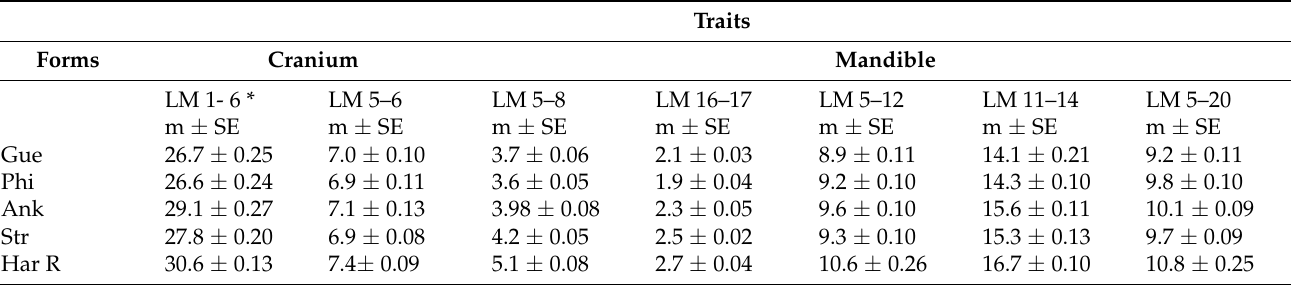
Table 2. Means and standard deviations of linear measurements (mm) in five vole forms: Har R: M. hartingi from the Rhodopes, Str: M. h. strandzensis , Ank: M. h. ankaraensis , Gue: M. g. guentheri, and Phi: M. g. philistinus . * See the corresponding landmarks in Figure 1. Traits Forms Cranium